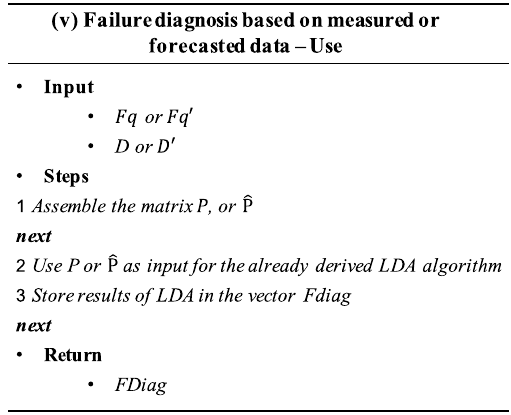
Figure 7. Forecasting notation.